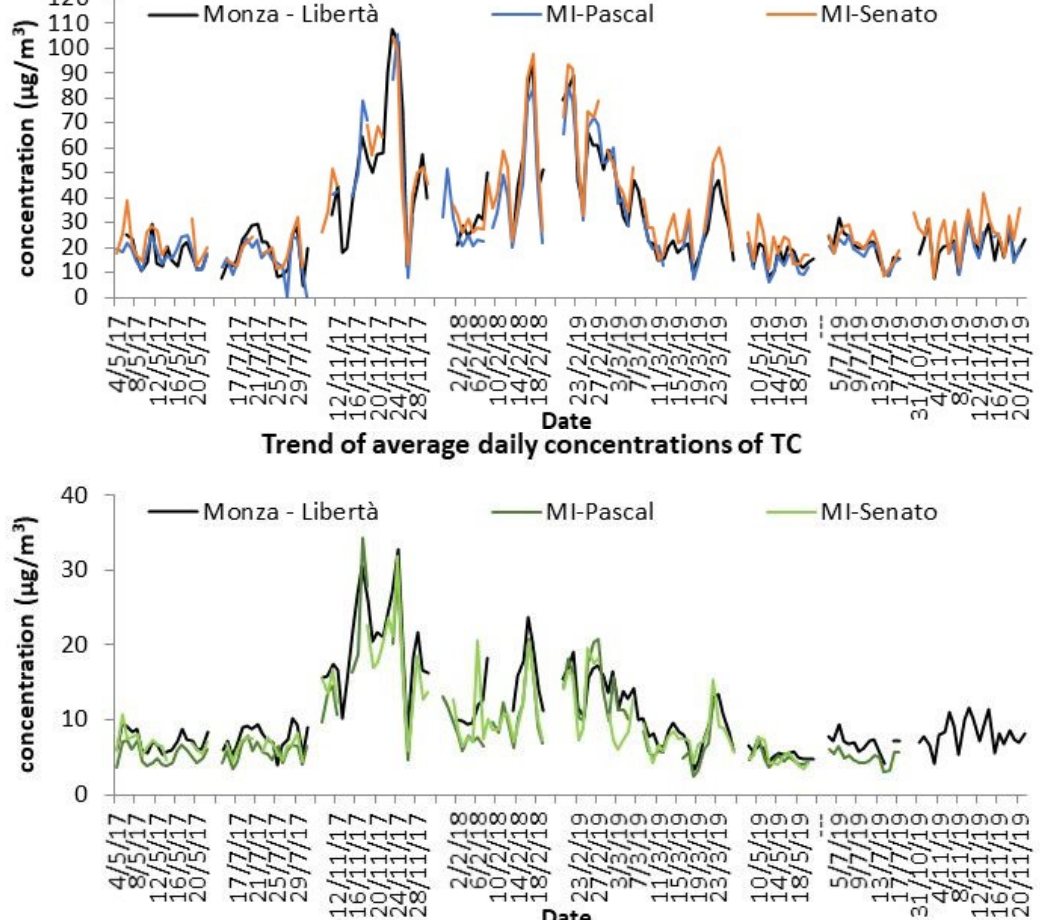
Figure 13: Average daily PM 10 (a) TC (b) concentrations measured in Monza – Libertà compared with those measured in Milan – Pascal and